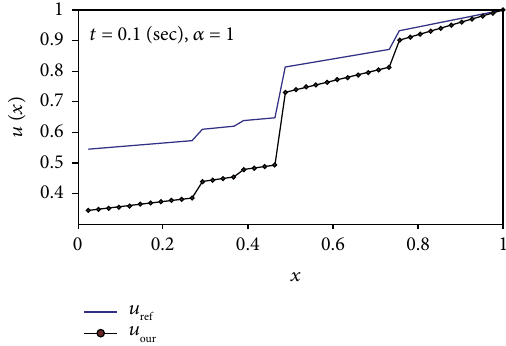
Figure 12: Variation of u ð x , t Þ versus x , with α = 0 : 33 , t = 0 : 3 sec .